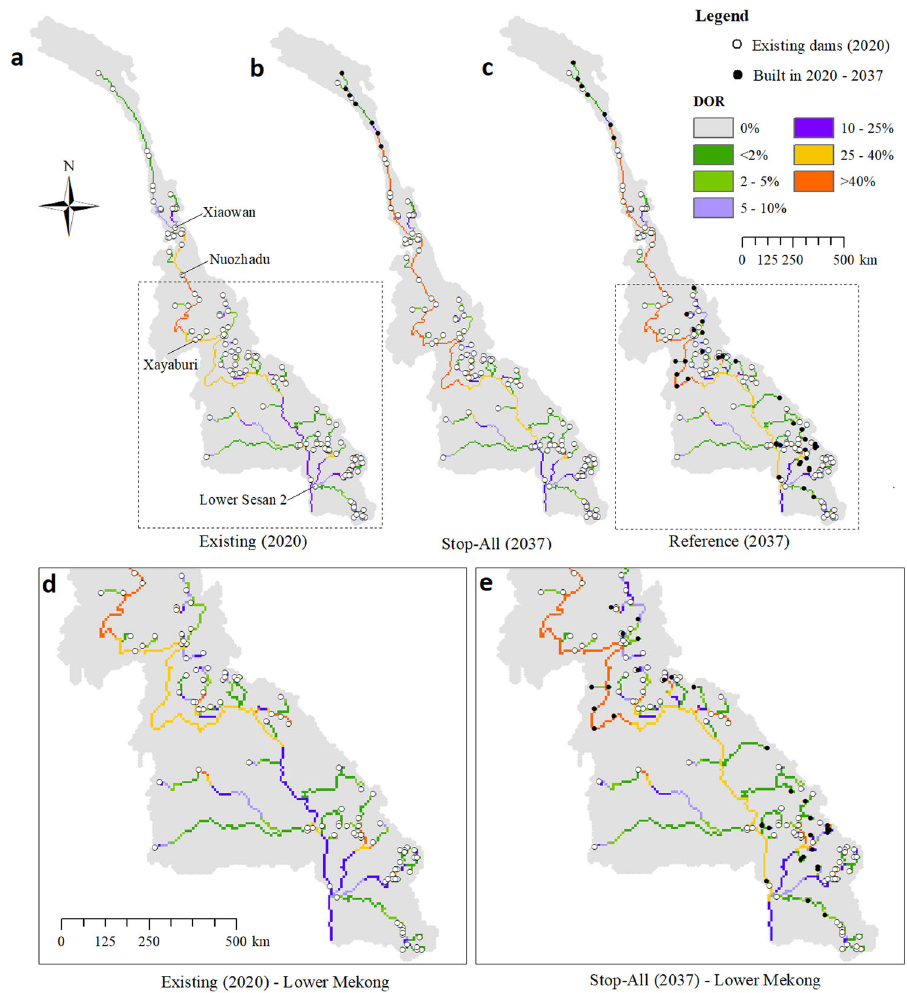
Fig. 6 Effect of dams on river fl ow. Change in the Degree of Regulation (DOR) between the current stage (2020) ( a ) and two dam development portfolios (Stop-All ( b ) and Reference ( c )) in 2037. The two insets in ( d , e ) highlight the dam development conditions and DOR for the Lower Mekong